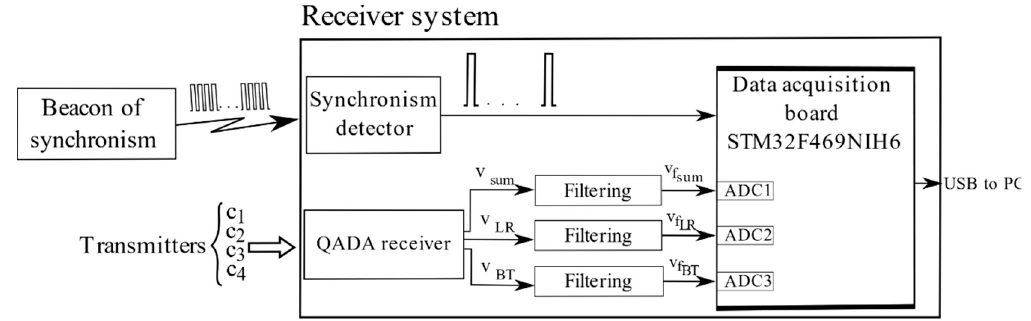
Figure 3. Block diagram of the reception system.